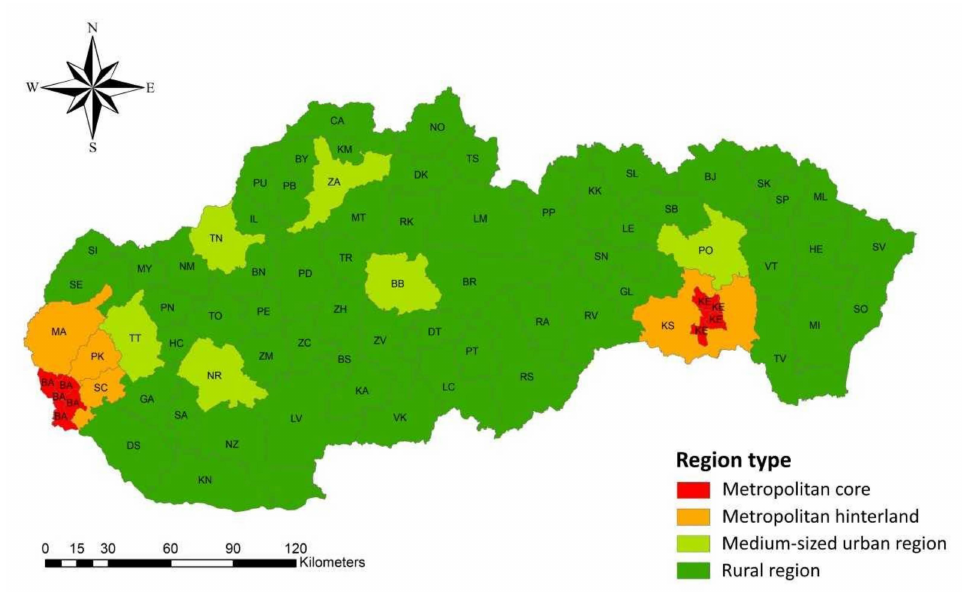
Figure 1. Typology of Slovak regions. Source: OECD 2012; the authors. Table 1. Variables used for the construction of the RDISK (years 1997, 2007, 2017). Indicator Unit Abbreviation Data Sources MIGR